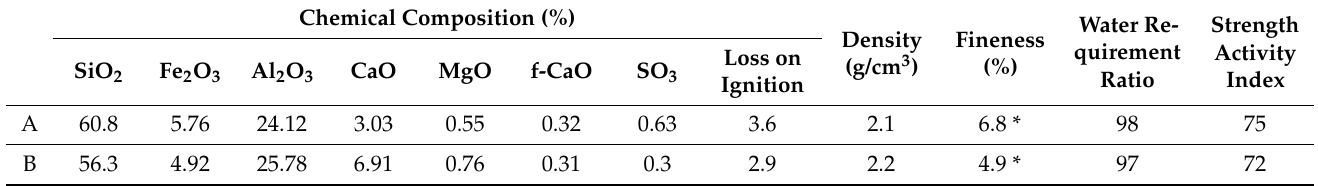
Table 2. Chemical Composition and Physical Properties of FA.